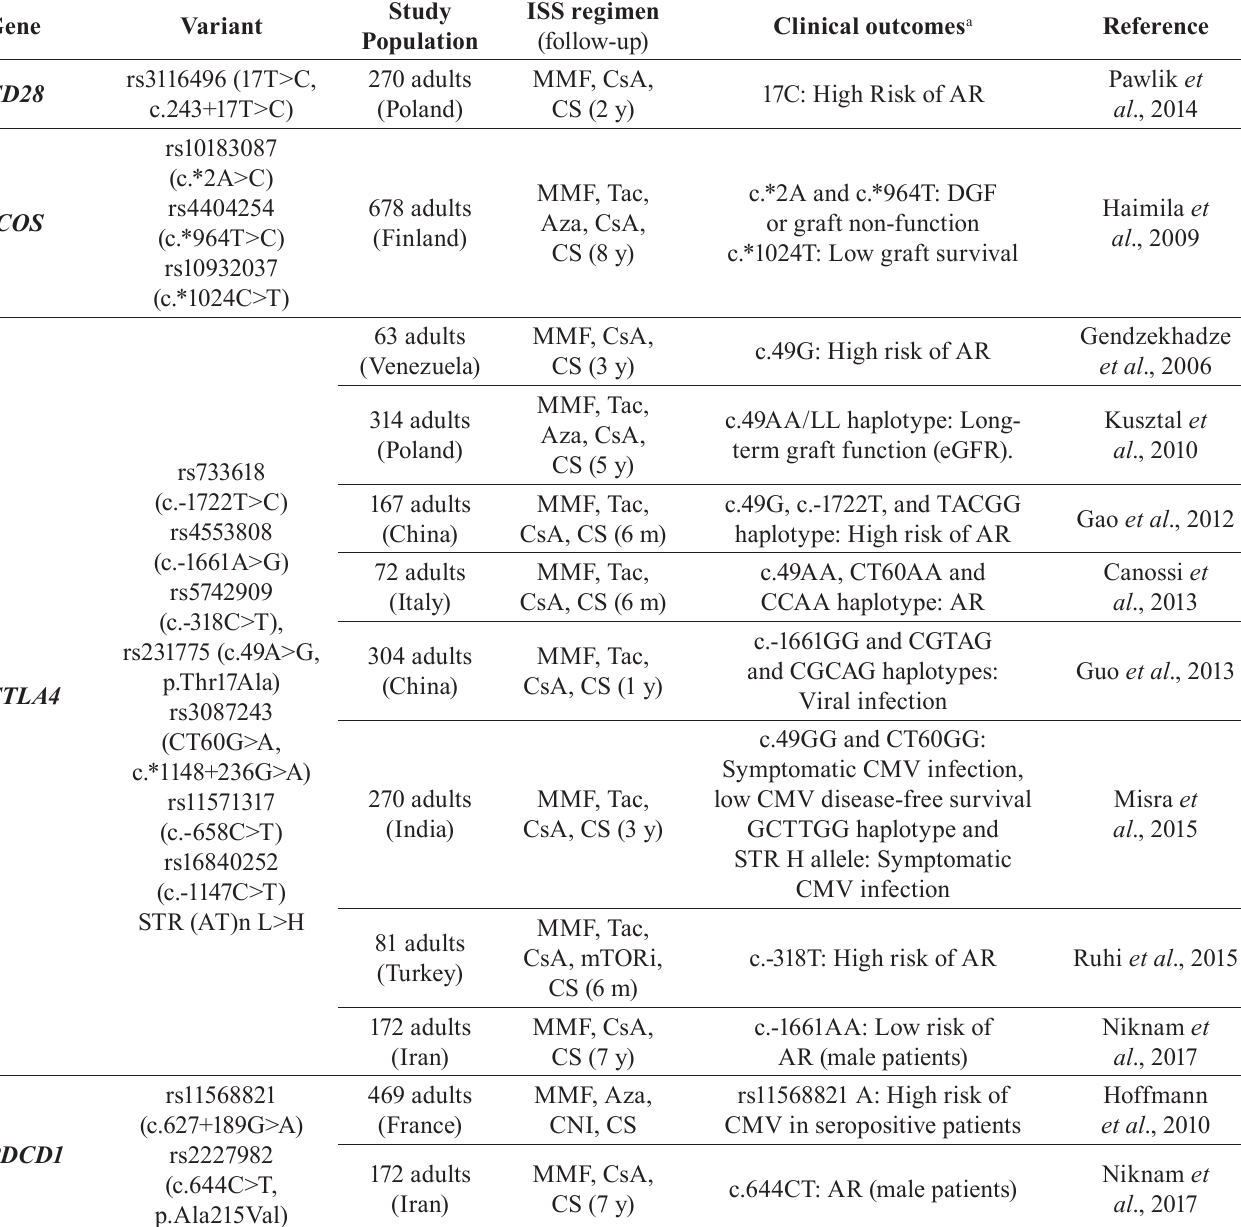
TABLE I - G enes related to T cell activation in kidney recipients on MPA therapy with significant associations